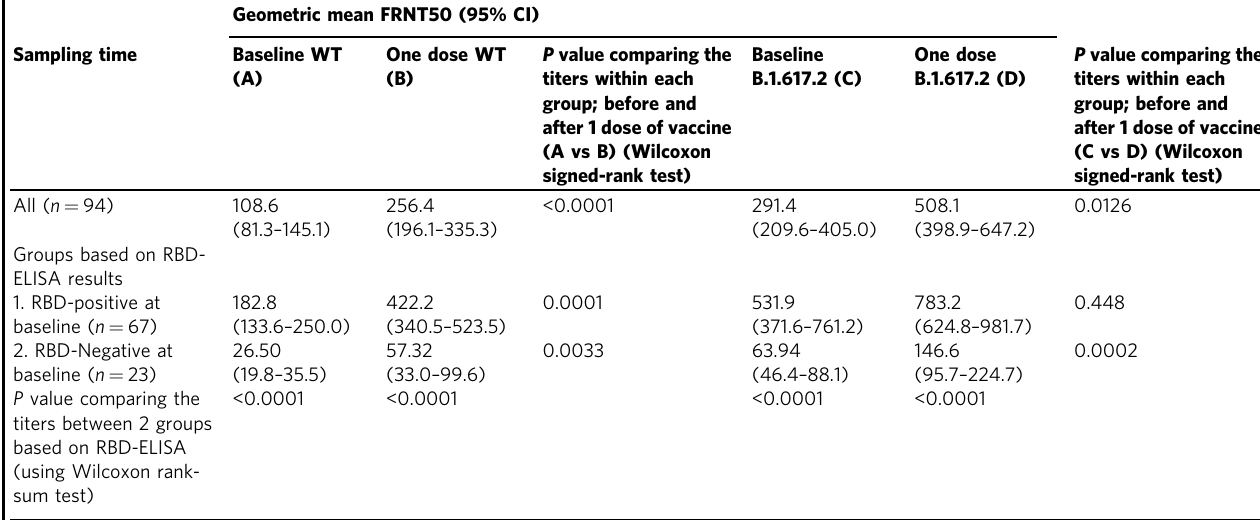
Table 1 Virus neutralization titers post single dose of BBV152 vaccination based on RBD-ELISA